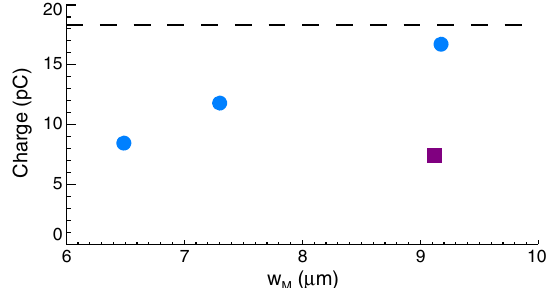
FIG. 5. Final trapped charge as a function of matched spot size ( w ) for the plasma channel. Blue circles are for the laser driver M focused at the entrance of the plasma while the purple square is for the laser driver focused at the point of collision. The dashed line represents the trapped charge without a plasma